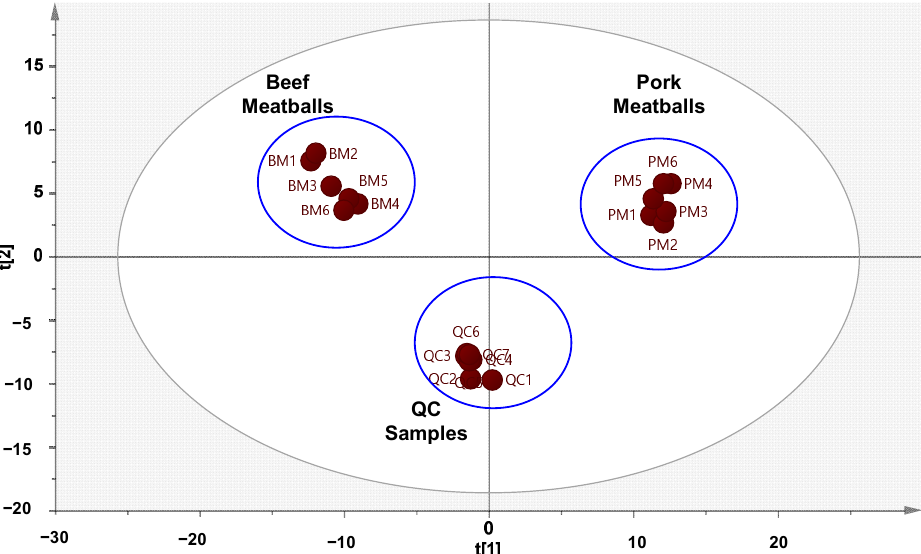
Figure 2. Principal component analysis (PCA) of meatballs made from beef and pork. (PC1 = 45.5%; PC2 = 24.0%).